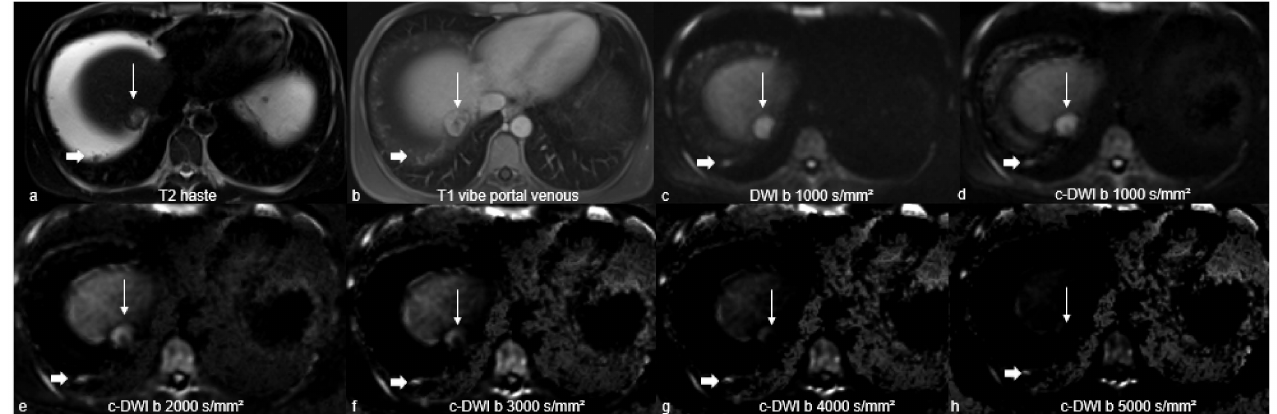
Figure 1. A representative patient of the patient sample with peritoneal carcinomatosis with primary cancer of hepatocellular carcinoma located perihepatically (thin arrow) on T2-weighted sequence ( a ), fat-saturated T1-sequence after contrast agent administration ( b ), axially acquired ( c ), and computed diffusion-weighted imaging at high b-values of 1000–5000 s/mm 2 ( d – h ). On DWI with a b-value of 1000 s/mm 2 ( c ), peritoneal carcinomatosis is as well visualised as on c-DWI with b-values of 1000 ( d ), and is better visualised than on c-DWI images at higher b-values (2000–5000 s/mm 2 ). Starting from high b-value of 2000 s/mm 2 ( e ), there is an increasing degradation of image quality. Note the additive discrete peritoneal nodules perihepatic (thick arrow) adherent to the peritoneum with concomitant